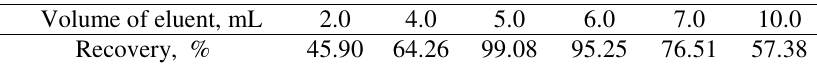
Table 2. Effect of volume of HCl solution on elution of Pb(II)